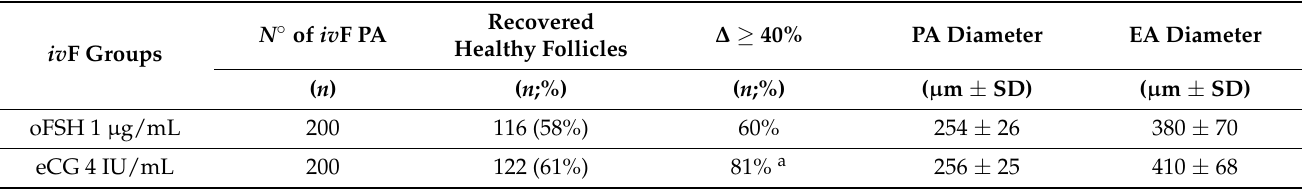
4 IU/mL) 116 and 122 follicles, respectively, were analyzed at the end of the in vitro culture for both follicular and oocyte performance. Only those follicles that differentiated the follicular antrum, identified on the stereomicroscope as a transparent cavity filled with follicular fluid, were tested. For each iv F group (oFSH 1 µ g/mL and eCG 4 IU/mL), 116 and 122 healthy oocytes were recovered and analyzed at the end of the in vitro culture to test the oocyte performance. Only the oocytes retrieved from follicles that differentiated the follicular antrum, identified on the stereomicroscope as a transparent cavity filled with follicular fluid, were tested. Parameters such as degree of PA follicle growth and % of follicles developing antrum overtime were calculated from healthy follicles (follicles with antrum cavity